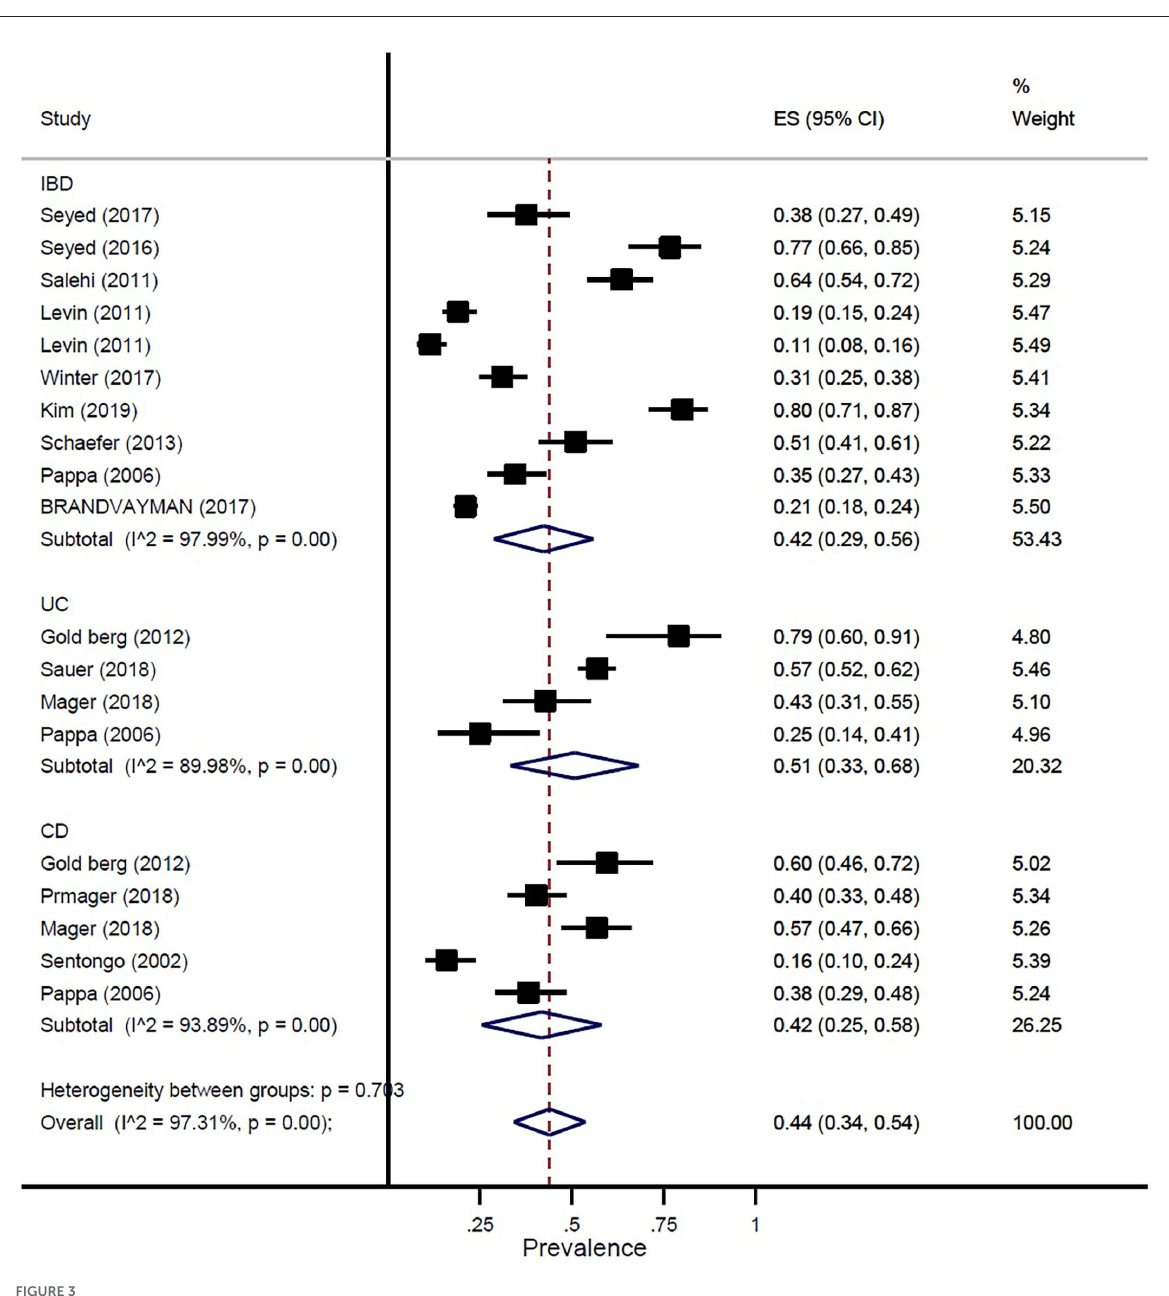
and the level of vitamin D of 20–30 ng/ml was